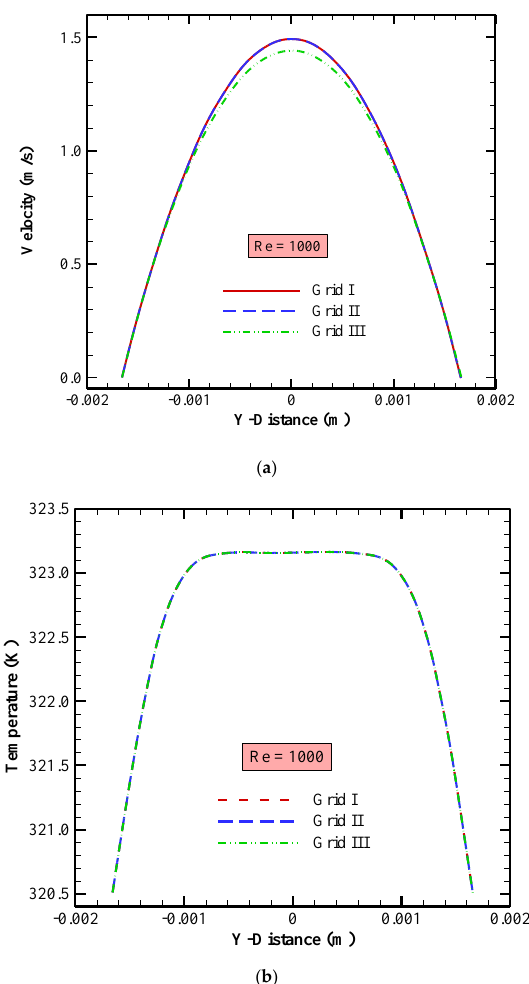
Figure 3. Grid independence test in terms of ( a ) local velocity and ( b ) local temperature.